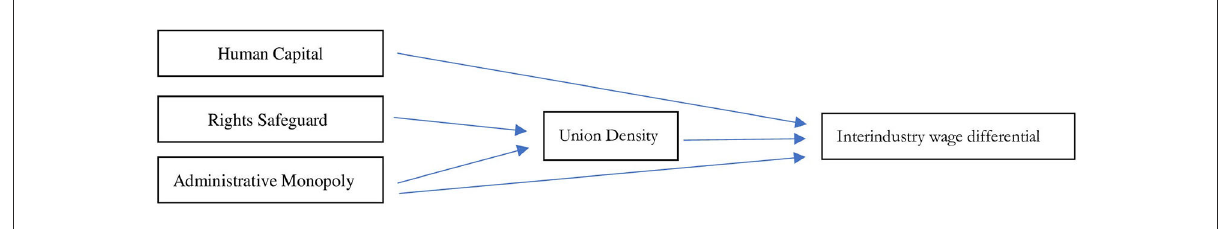
FIGURE1 The expected relationship between union density and